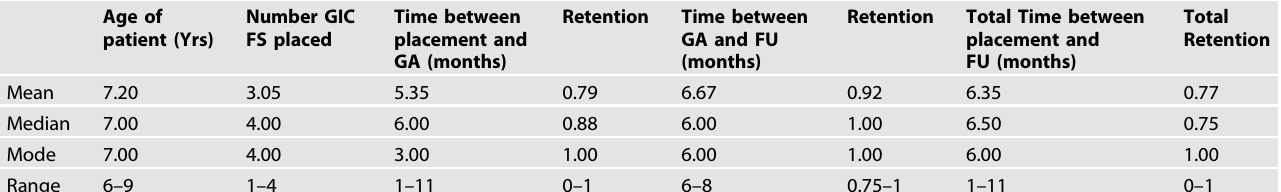
Table 1. Average retention of GIC-FSs at follow-up